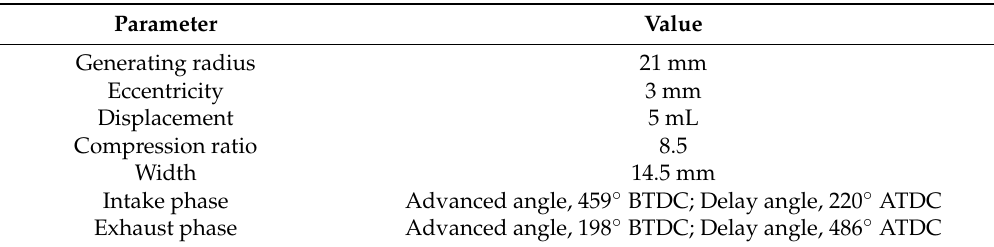
Figure 1. Schematic of small rotary engine. Table 1. Small rotary engine specifications.